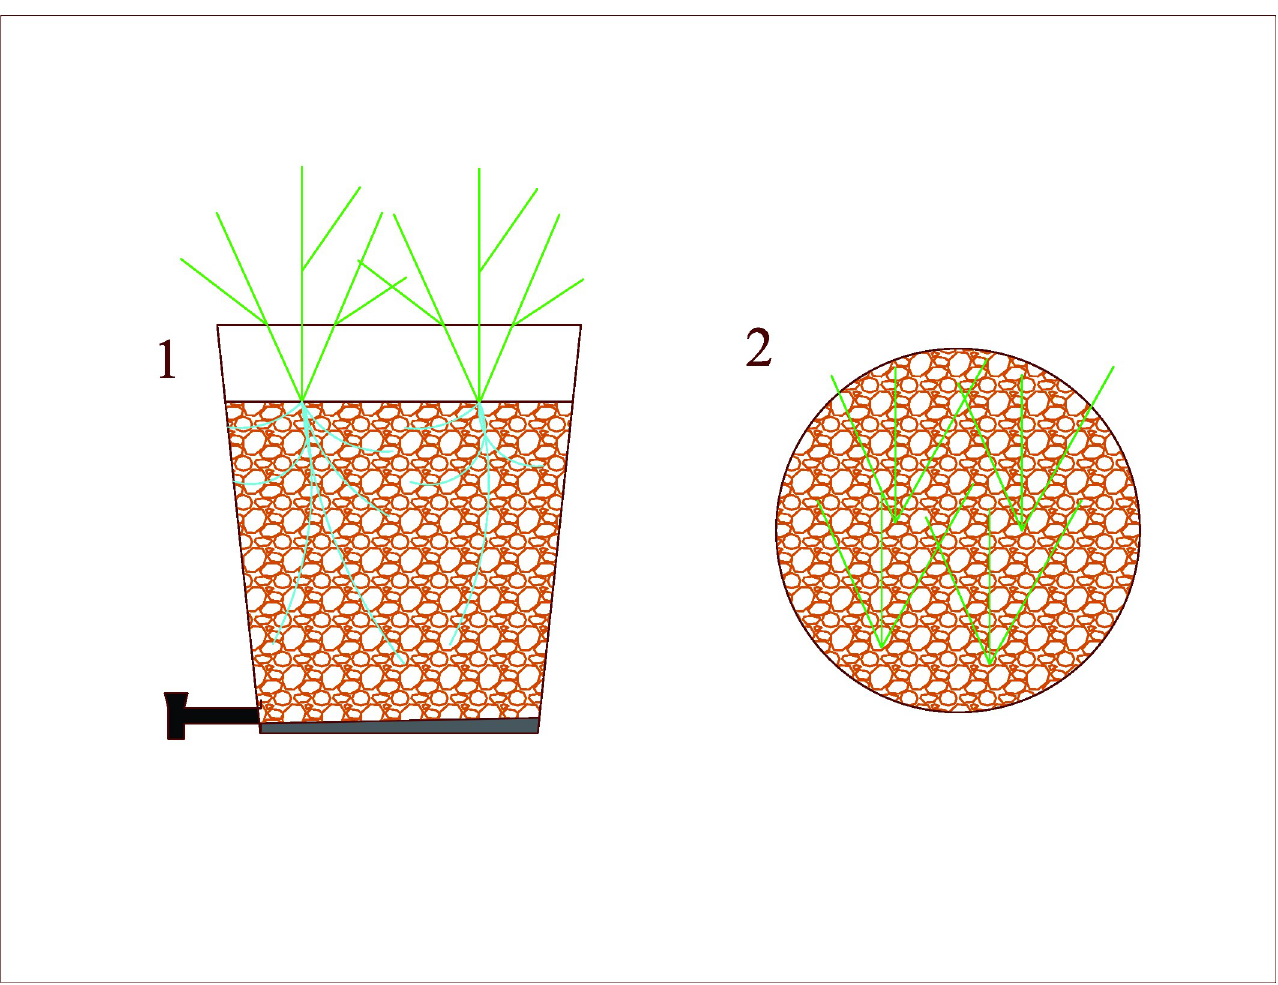
Fig 1. Scheme of the experimental system, 1—cross section and 2—upper view of the system.